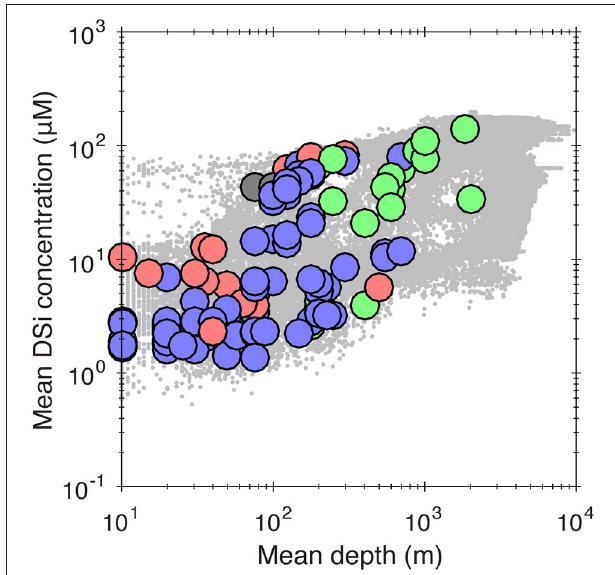
FIGURE 6 | Cross-plot of mean habitat depth and mean ambient dissolved Si concentrations for all sponge families in the GBIF database. See previous figures for key to colors. All taxa are included regardless of their abundance, unlike Figures 3 – 5 where an occurrence criterion of 100 WOCE boxes is imposed. Data are aggregated at the presence/absence level for individual WOCE boxes. Gray dots in the background are ocean bottom water dSi concentrations (i.e., the same data as Figure 1